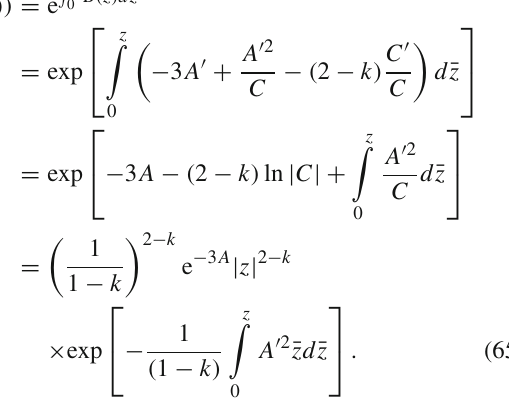
Fig. 2 The shape of the Elko zero mode α 0 ( z ) in Eq. (63) in the thick brane models with A ( z ( y )) = − b ln cosh ( ay ) . The parameters are set to b = 1, a = 1 and k = 1